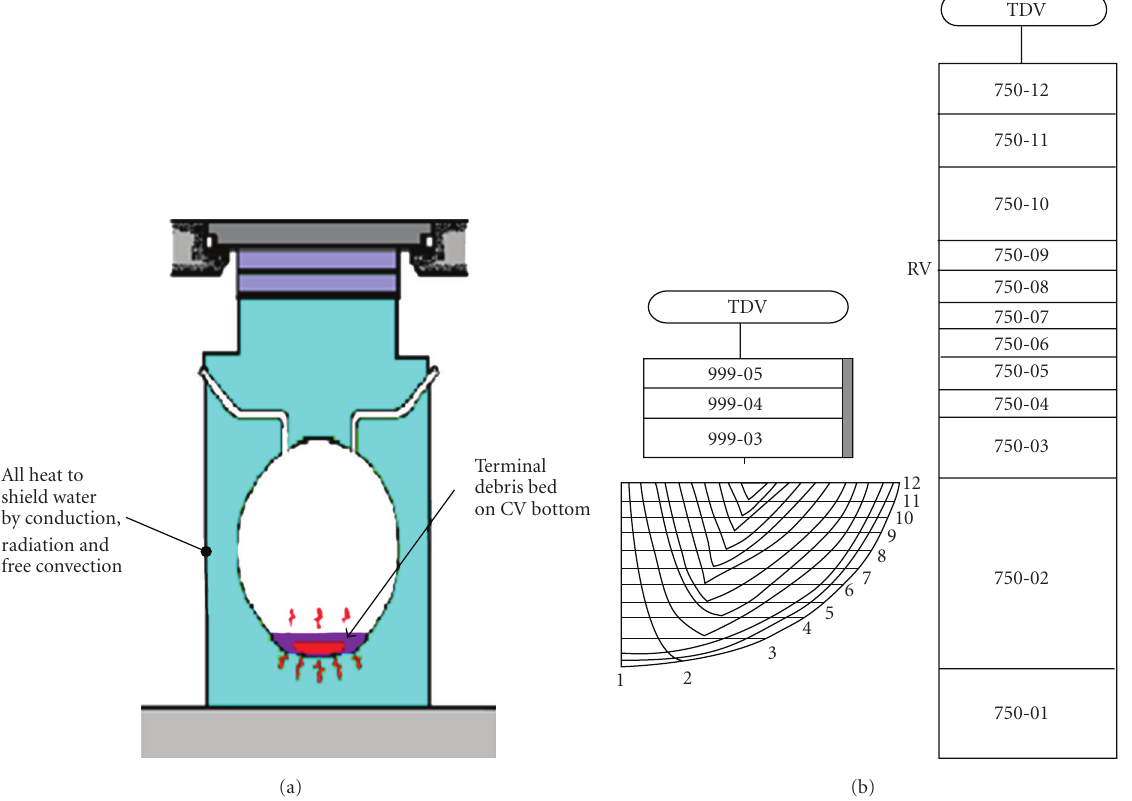
Figure 16: RELAP, SCDAP, and COUPLE module nodalization and conceptual sketch for CANDU-6 calandria vessel analysis.